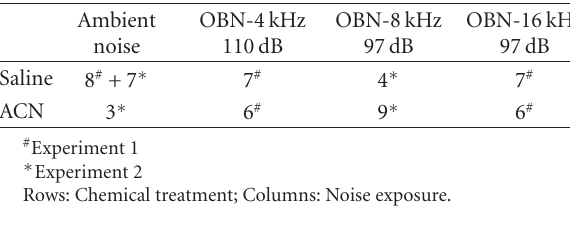
Table 1: Experimental groups and treatment